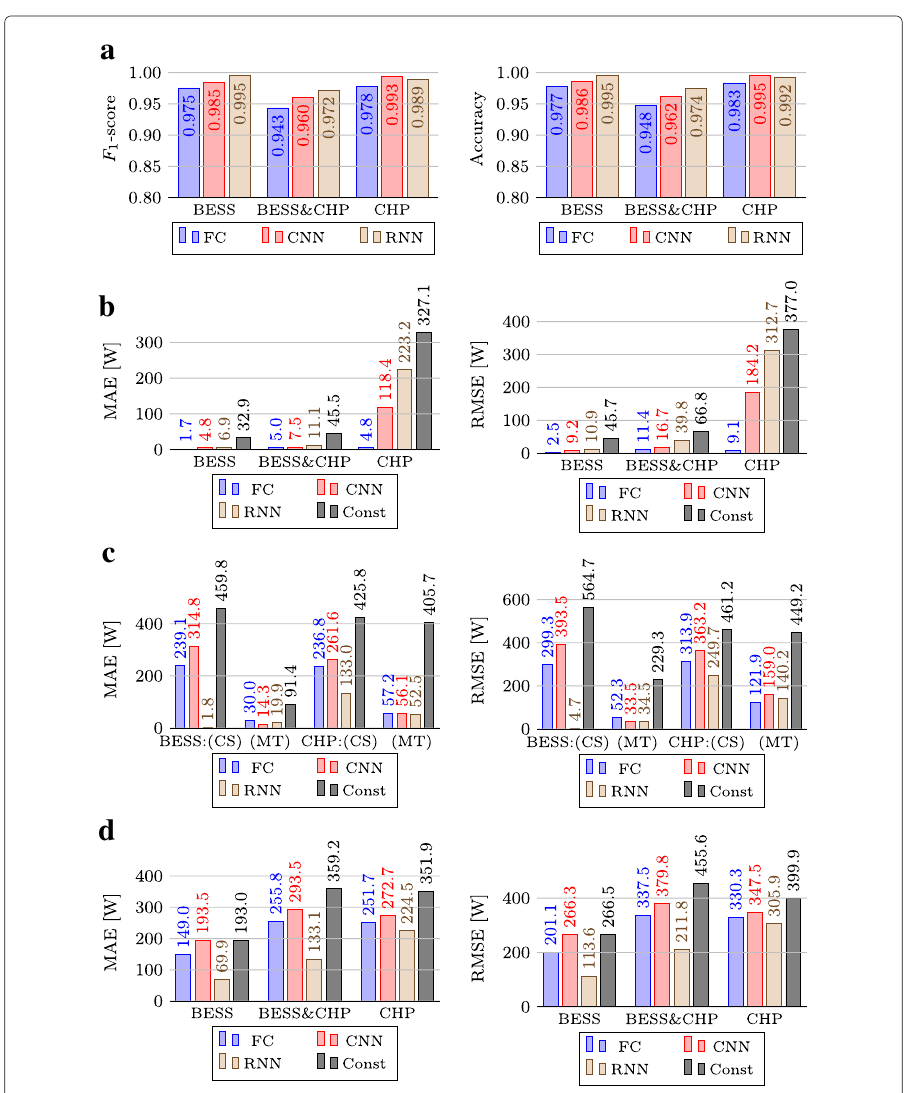
Fig. 5 Results for an ANN with a fully-connected feed-forward topology (FC), a convolutional neural network (CNN), and a recurrent neural network (RNN). a Classification Performance, b Load Prediction based on Price Profiles, c Load Generation based on Control Vectors, d Load Profile Repair (repairing only infeasible